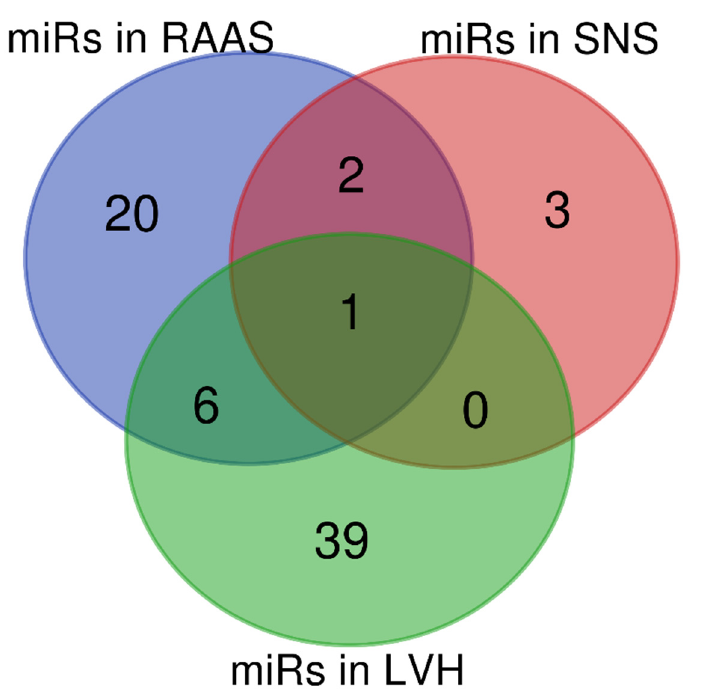
Figure 2. MiRNAs regulating RAAS, SNS and LVH.